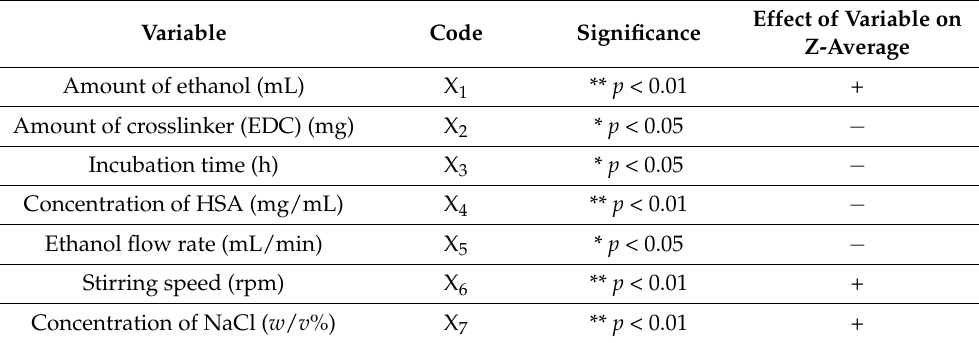
Table 5. Effects of the 7 investigated processes and material parameters on the Z-average of HSA nanoparticles produced by the rapid coacervation method. Statistical analysis: One-way ANOVA, α = 0.05. (* p < 0.05; ** p < 0.01 significant).